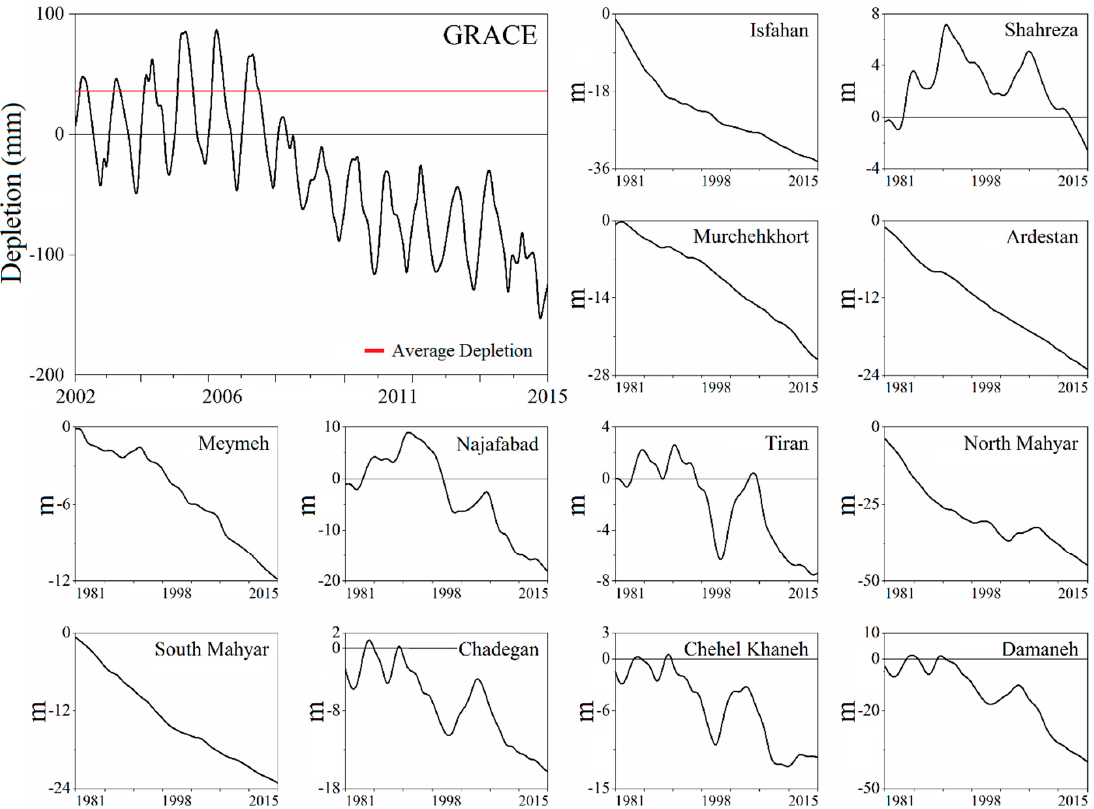
Figure 3. The water mass depletion in the Zayanderud Basin based on data derived from the gravity recovery and climate experiment (GRACE) mission. Figure 3 also shows the groundwater depletion rate in meters in the 12 biggest aquifers in the Basin. Y Axis: GRACE depletion in (mm), groundwater depletion level in (m).